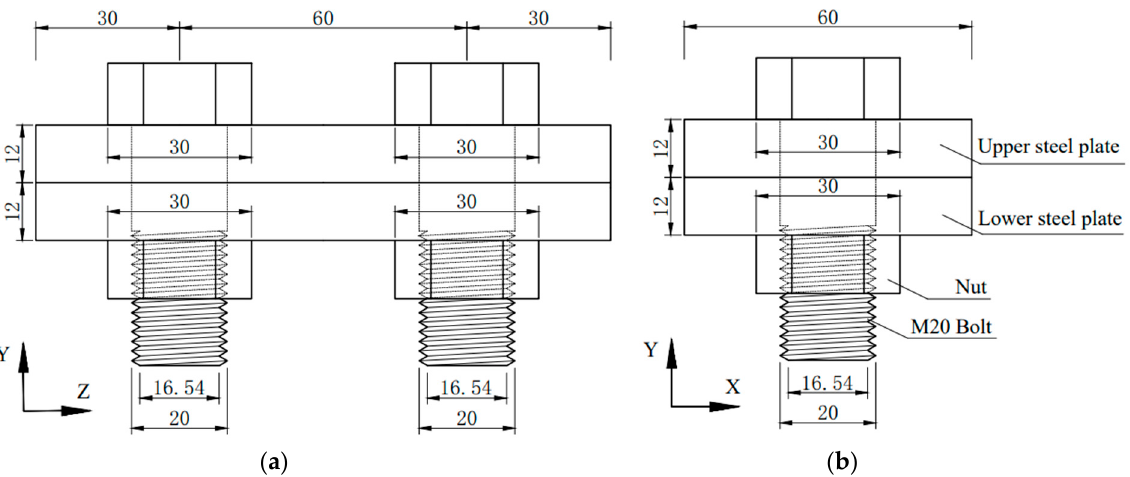
Figure 4. Schematic Diagram of Design Model: ( a ) Front view of design model; ( b ) Side view of design model.